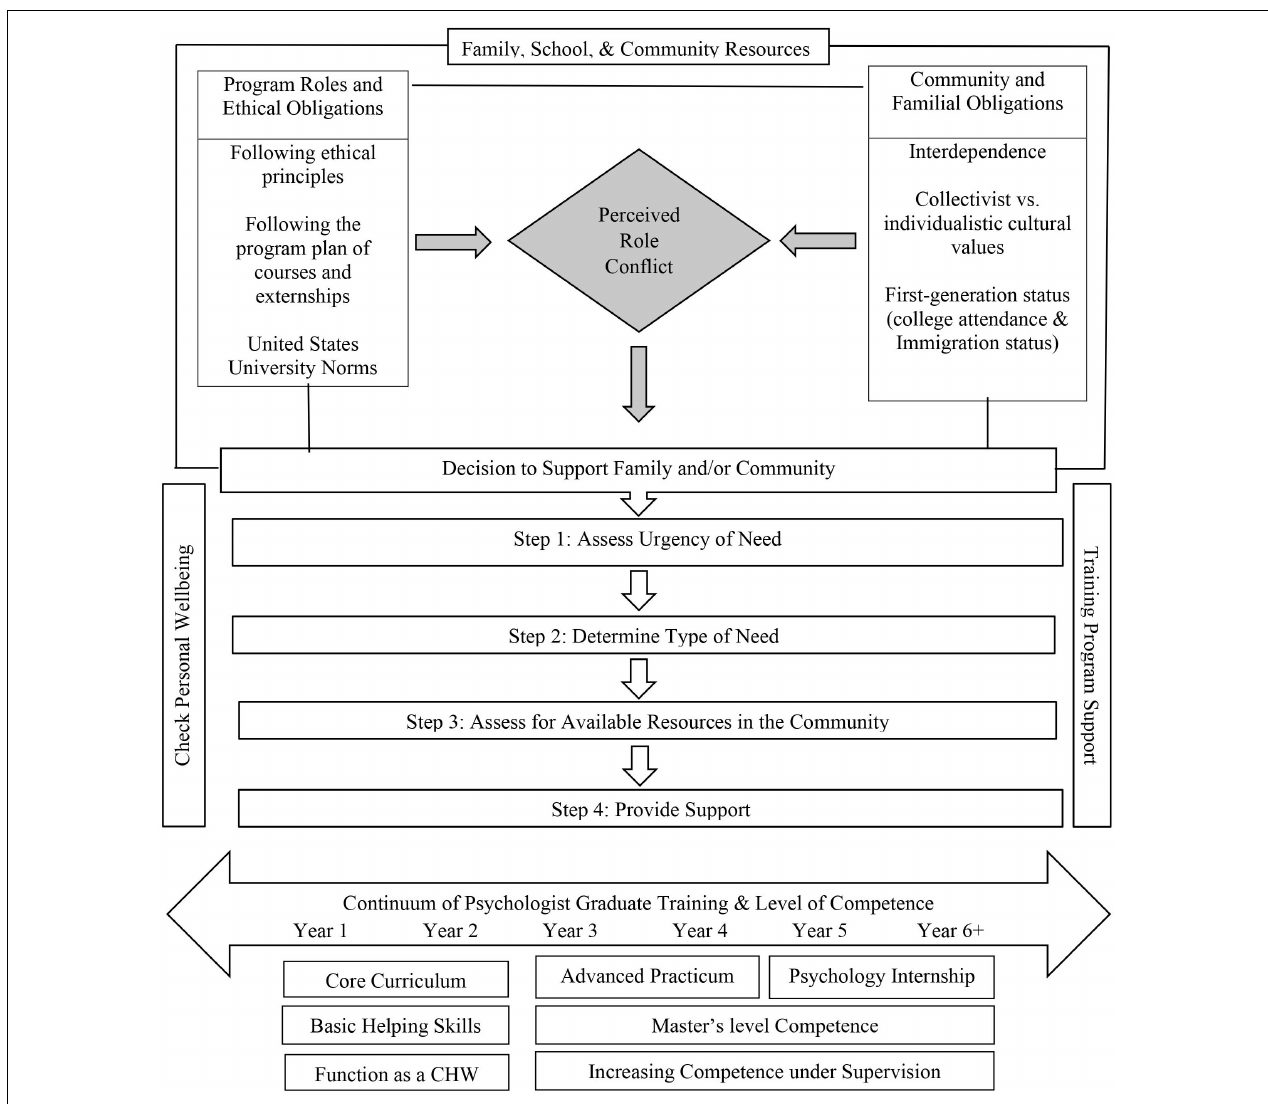
FIGURE 1 | Proposed Decision-Making model for addressing role conflict for psychology